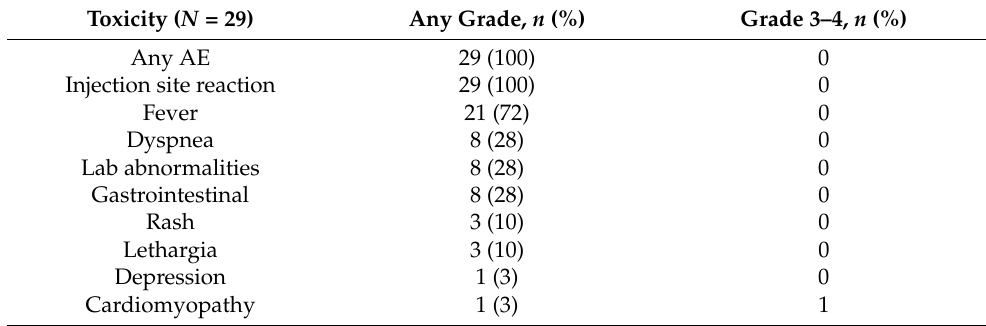
Table 3. Compiled toxicities of